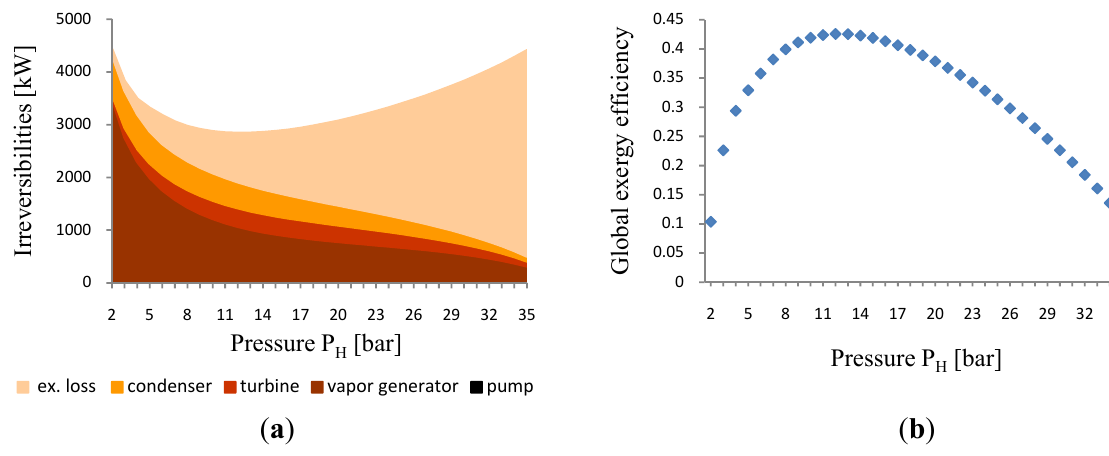
Figure 4. R-245fa global performance from almost dry resource. ( a ) Irreversibilities diagram; ( b ) Global exergy efficiency